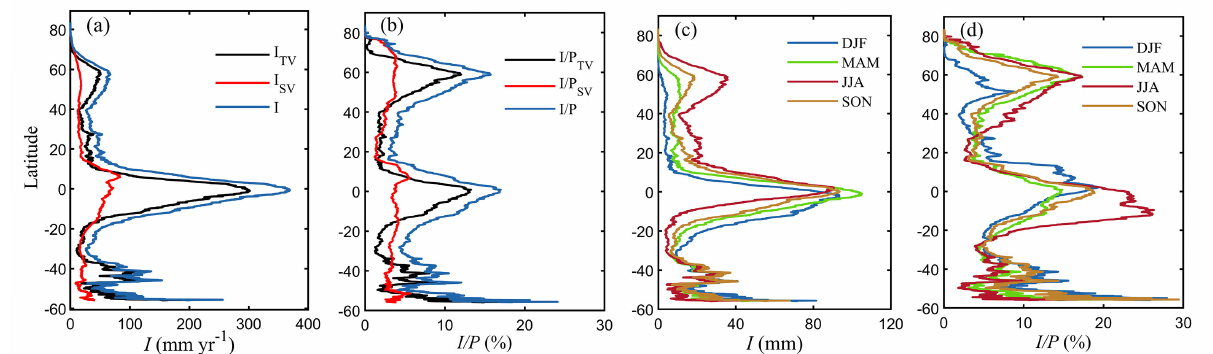
Figure 5. Variation of average I along different latitudinal bands. (a) I (mmyr − 1 ) for tall vegetation, short vegetation and their sum. (b) Same but for I/P (%). Seasonal patterns of I (in mmyr − 1 ) (c) and of I/P in % (d) . DJF, MAM, JJA and SON represent